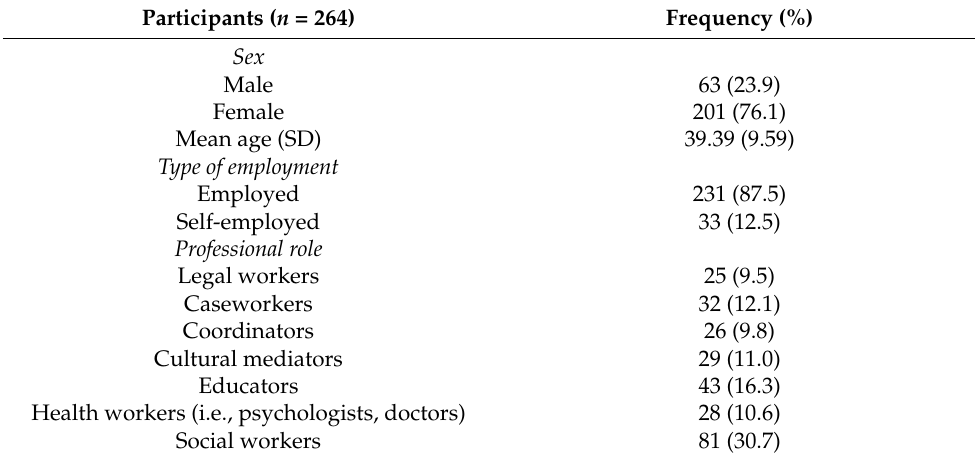
Table 1. Characteristics of